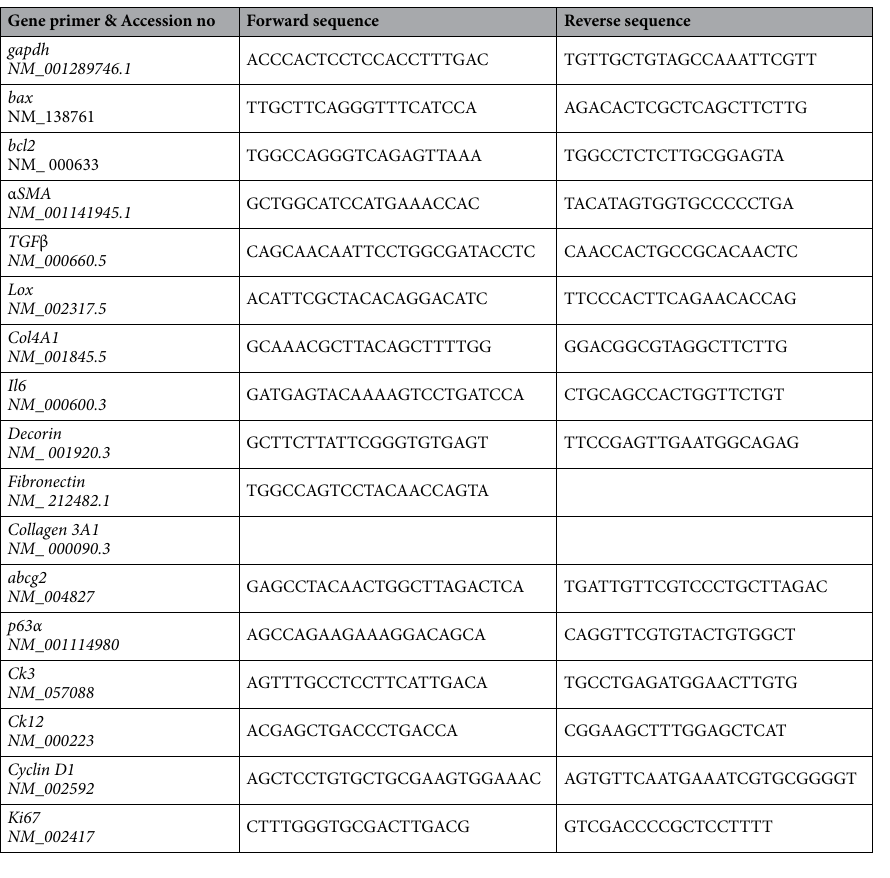
Table 1. Primers used in